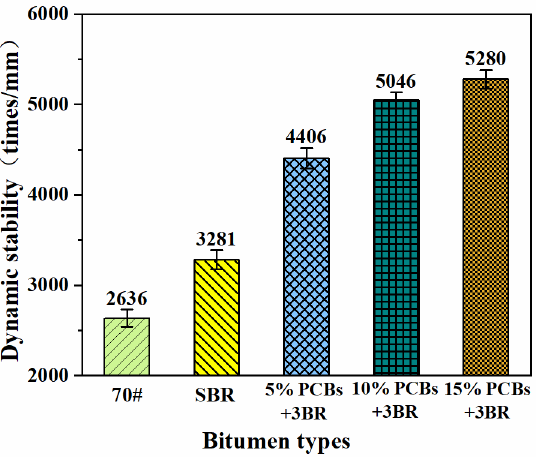
Figure 10. The results of PS modified bituminous mixture wheel tracking test.